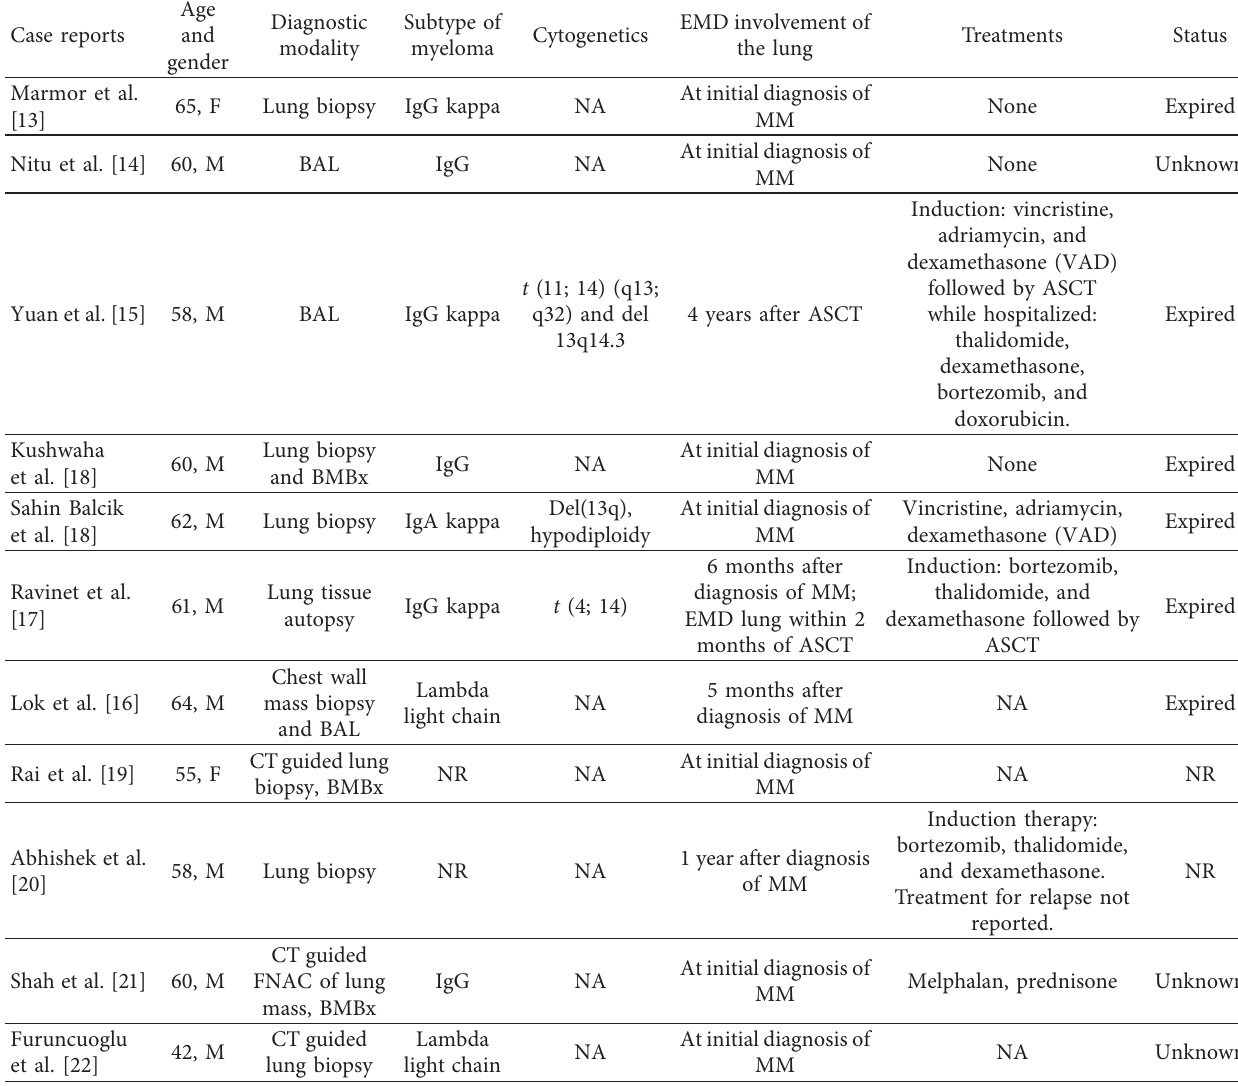
Table 1: Summary of case reports with myelomatous lung involvement and their